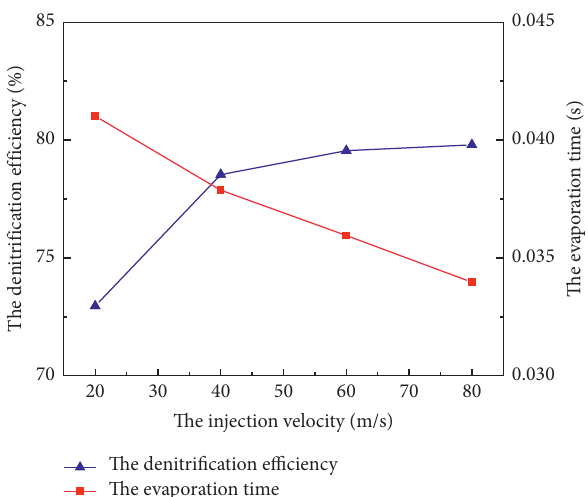
Figure 11: Evaporation time of urea solution and denitrification efficiency at different injection velocities.